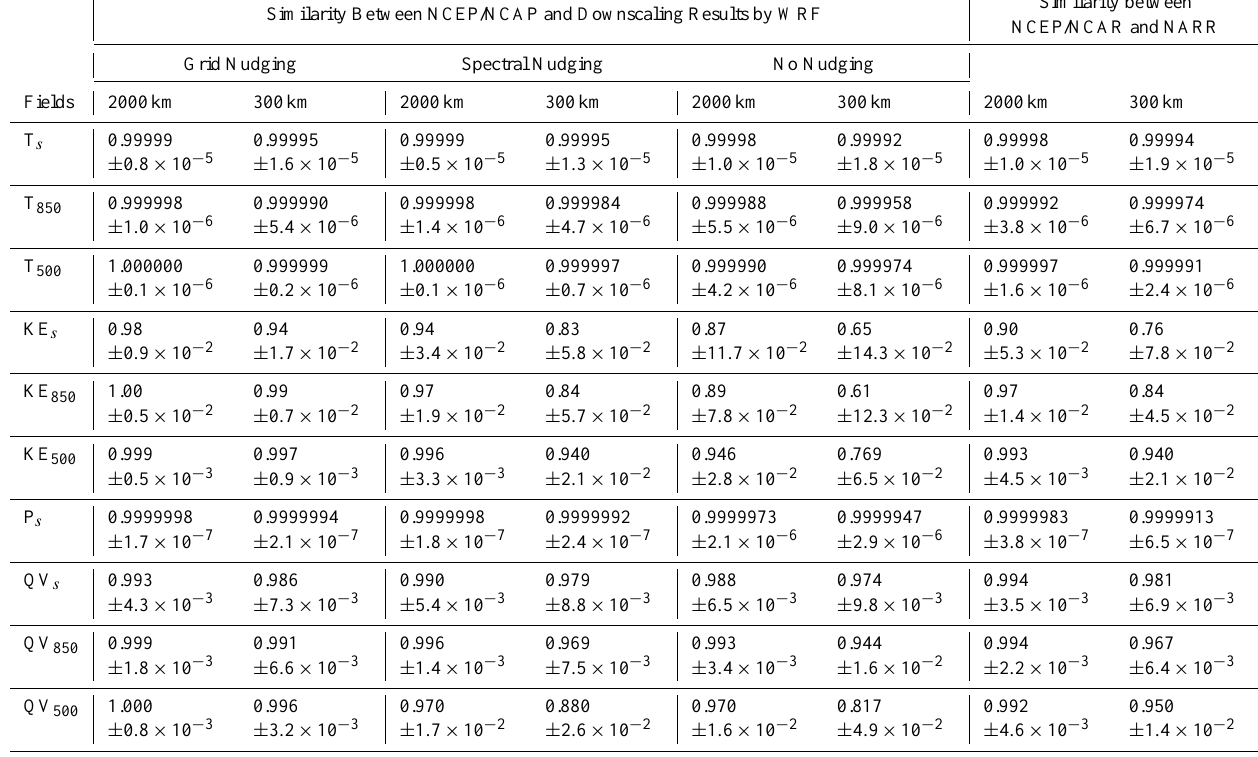
Table 1. Summary of the Mean and Standard Deviation of Similarities for Temperature, Kinetic Energy (KE), Surface Pressure and Water Vapor Mixing Ratio (QV) of July 2009 at Different Scales.